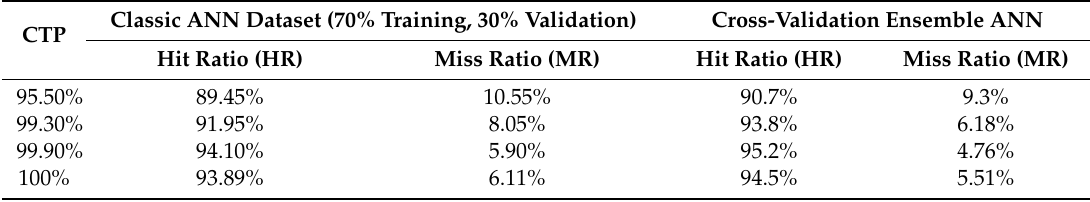
Table 4. Comparison of classic ANN and the cross-validation ensemble technique.